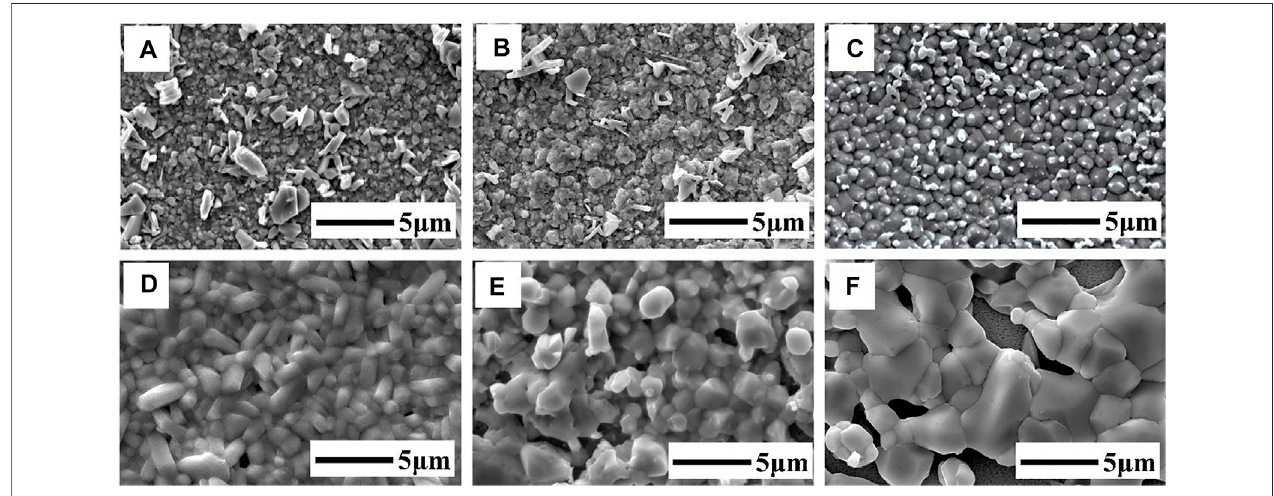
FIGURE 6 | FE-SEM images of the CuSbS 2 thin fi lms annealed at different temperatures: (A) 300 ° C, (B) 320 ° C, (C) 340 ° C, (D) 360 ° C, (E) 380 ° C, (F) 400 ° C.